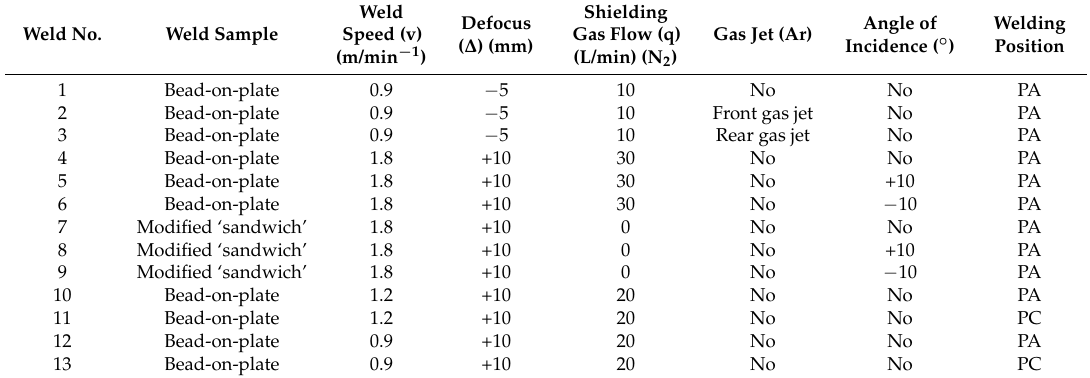
Table 1. Welding parameters with different penetration